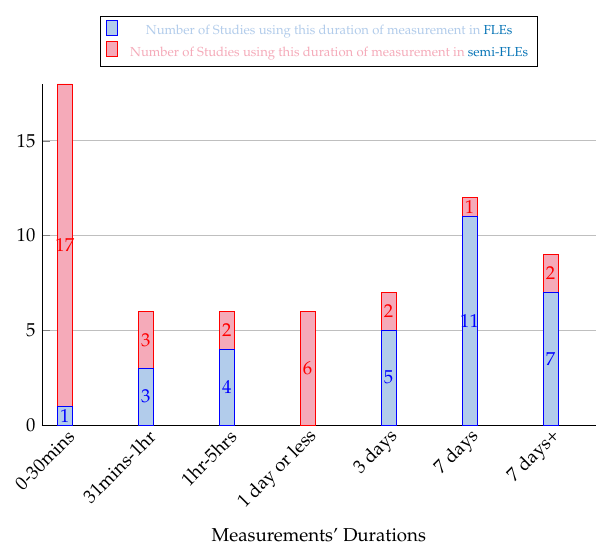
Figure 11. Measurements’ Durations in in FLEs and semi-FLEs studies.